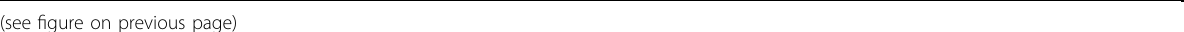
Fig. 6 BA72018/7125 and BA7208 protected mice from SARS-CoV-2 variant infection. a BA72018/7125 and BA7208 were administrated to K18- hACE2-transgenic and BALB/c (wt) mice (6 – 8 weeks old, female) intraperitoneally at a dose of 10 mg/kg 24 h before (prophylactic, abbreviation P) or 4 h after (therapeutic, abbreviation T) SARS-CoV-2 Omicron BA.1 or BA.2 infection (1 × 10 5 FFU, intranasally). PBS was administrated as a negative control. b Lungs were harvested for viral titers at 1 day post infection (dpi) for prophylactic and therapeutic group ( n = 3 or 4 mice per group) by FFA method. LOD limit of detection, g gram,. wt BALB/c wt mouse, K18 K18-hACE2-transgenic mouse. c BA7208 and BA72018/7125 were administered via intranasal at a dose of 1 mg/kg 24 h before (prophylactic, abbreviation P) or 4 h after (therapeutic, abbreviation T) SARS-CoV-2 Omicron BA.2 infection (1 × 10 5 FFU, intranasally). Lungs were harvested for viral titers at 1 dpi. ( n = 3 or 4 mice per group). d BA72018/7125 and BA7208 were administered via aerosol inhalation at a dose of 3 mg/kg 24 h before (prophylactic, abbreviation P) or 4 h after (therapeutic, abbreviation T) SARS-CoV-2 Omicron BA.2 infection (1 × 10 5 FFU, intranasally). Lungs were harvested for viral titers at 1 dpi. ( n = 3 or 4 mice per